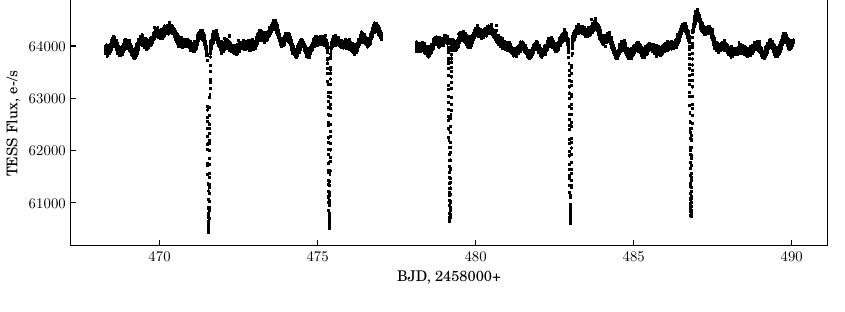
Figure 6. TESS photometry of